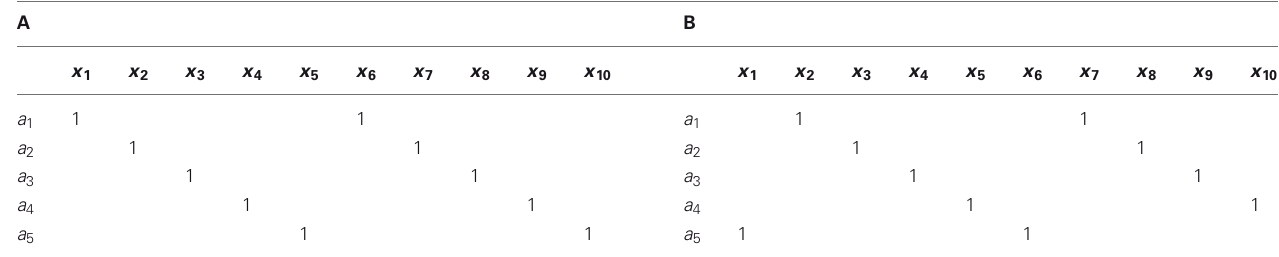
Table 2 | Illustration of state-action-reward